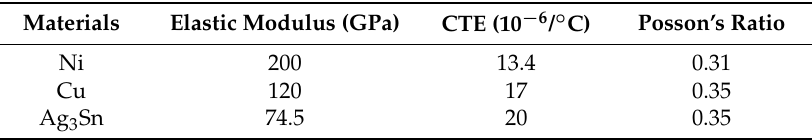
Table 1. Material mechanical parameters